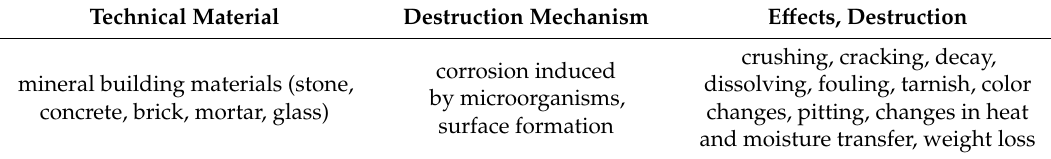
Table 5. Mineral technical materials that are subject to decomposition or microbiological corrosion